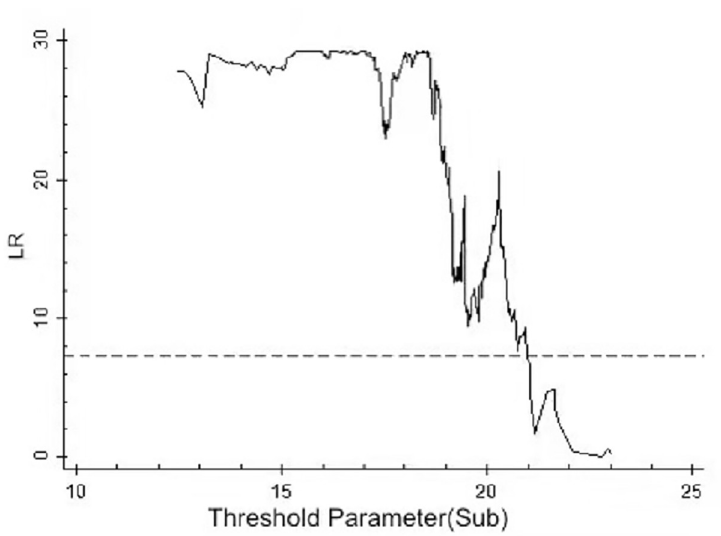
Fig 6. Estimated value and confidence interval of the second threshold in Model